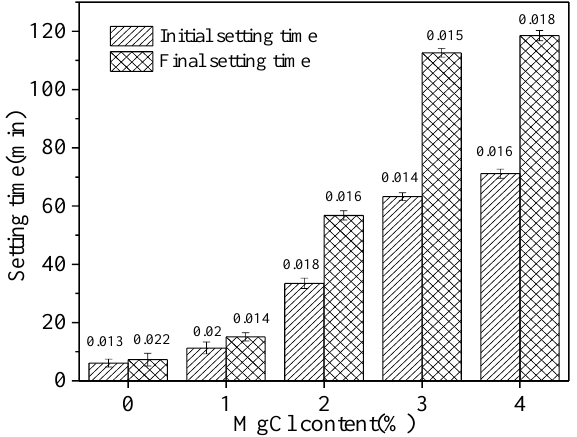
Figure 4. The setting time of cement paste.